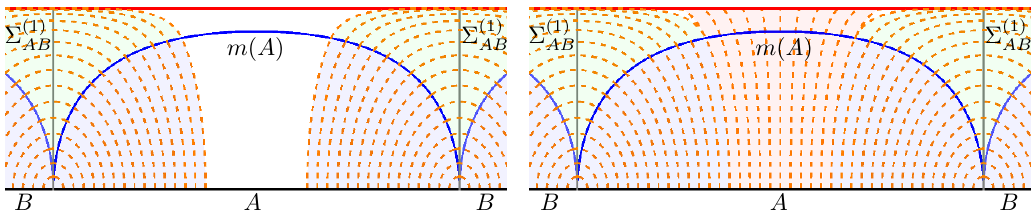
Figure 8 . Integral curves (dashed orange) of the vector (cid:12)eld con(cid:12)gurations whose (cid:13)ux through A computes the entanglement of puri(cid:12)cation E ( A : B ) (left) and the entanglement entropy S ( A ) (right). The latter one also computes the entanglement of puri(cid:12)cation E ( A : B ) as the part of the (cid:13)ux that goes through (cid:6) (1) . The shaded regions correspond to di(cid:11)erent sections of the vector (cid:12)eld AB that are glued together. The green region corresponds to a maximally packed (cid:13)ow and, as discussed in the text, it is constructed by exploiting the nesting property of entanglement entropy. The blue region inside m ( A ) represents the continuation of the same thread bundle based on the geodesic (cid:13)ows constructed in section 2. The red region in the right (cid:12)gure corresponds to an extra bundle that is added, and is also based on a geodesic (cid:13)ow. The threads in this region necessarily end at the horizon and hence their (cid:13)ux has a purely thermal interpretation. The white regions correspond to patches where the vector (cid:12)eld vanishes, i.e., V = 0. In both (cid:12)gures we have chosen to symmetrize the vector (cid:12)eld around (cid:6) (1) so the regions x > ‘= 2 and x < (cid:0) ‘= 2 are obtained by a re(cid:13)ection AB around these